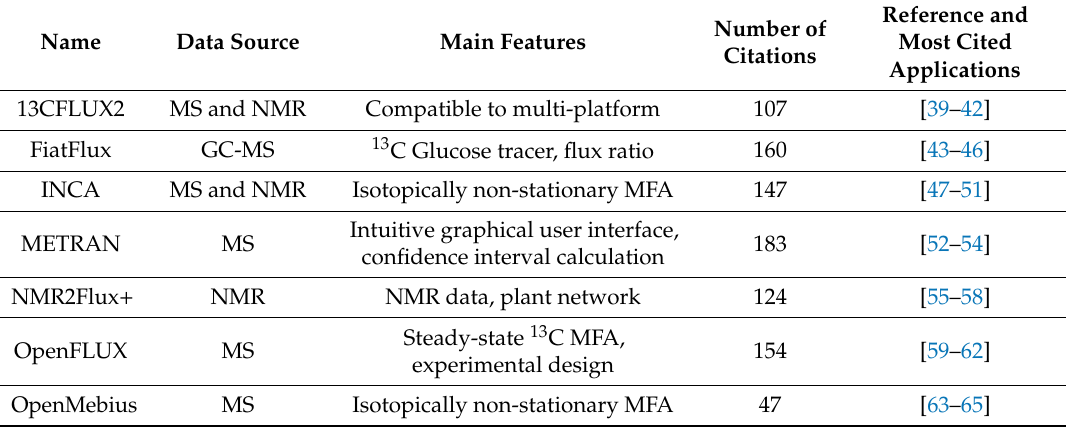
Table 1. Commonly used software tools for metabolic flux analysis